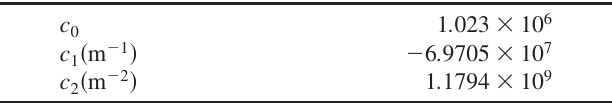
TABLE IV. Coefficients found from the quadratic regression. c 0